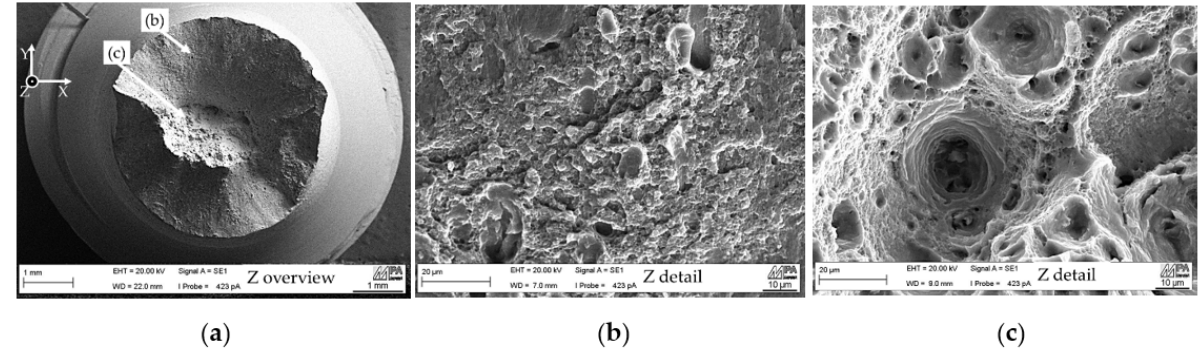
Figure 4. ( a ) Overview of an exemplary fracture surface of a standing (Z) and heat treated tensile specimen. ( b ) Exemplary detailed view with less dimples. ( c ) Exemplary detailed view with dimples.